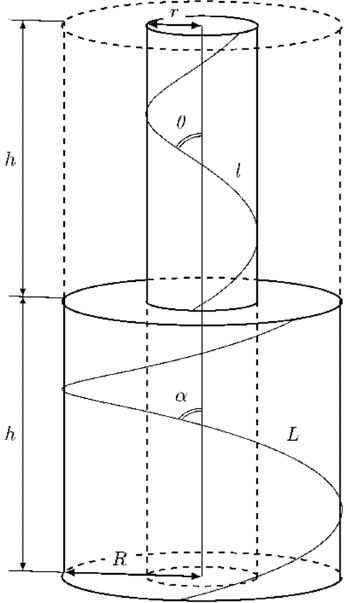
Figure 2. Idealized helical trajectory (based on [49]).